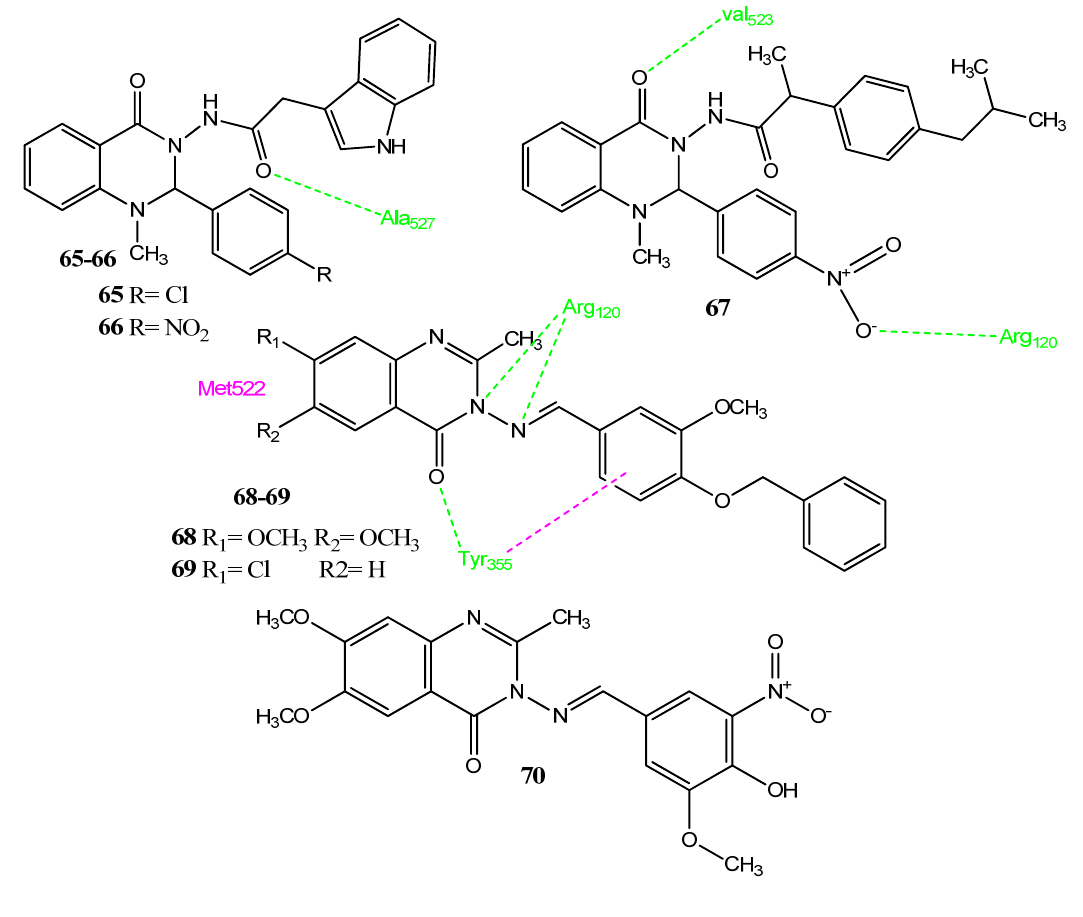
Figure 14. Quinazolinone